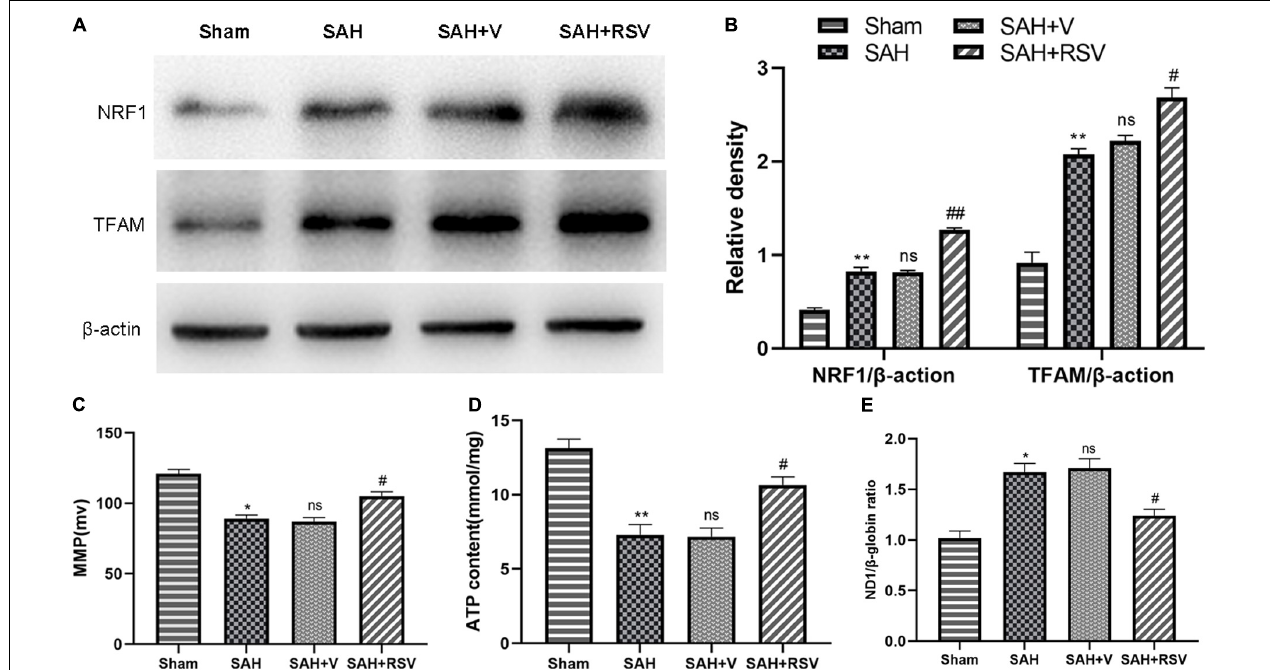
FIGURE 6 | Effect of RSV on the expression of PGC-1 α downstream proteins was determined after SAH. (A) The expression of NRF1 and TFAM was elevated following SAH. Moreover, RSV further upregulated the expression in the temporal cortex after SAH ( n = 6). (B) The ratios of NRF1 and TFAM. Relative protein levels were standardized with respect to β -actin protein. (C) MMP. (D) Intracellular ATP content. (E) mtDNA content. Data were represented as mean ± SEM ( n = 6). * p < 0.05 and ** p < 0.01 vs. sham group; ns p > 0.05 vs. group with SAH; # p < 0.05 and ## p < 0.01 vs. vehicle-treated group.